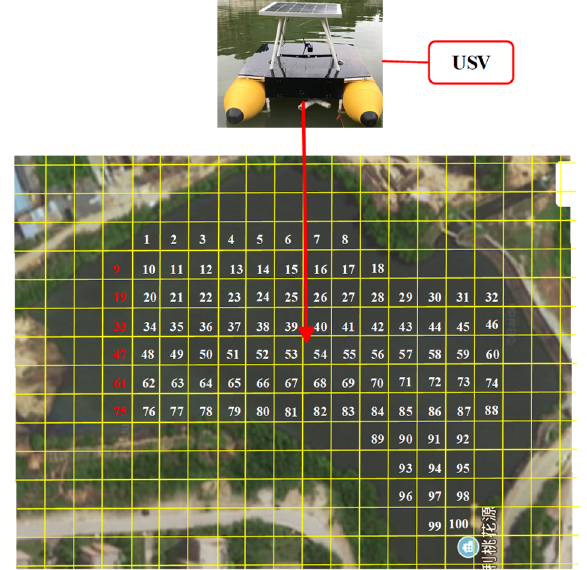
Figure 9. Locations of the water sample extraction.